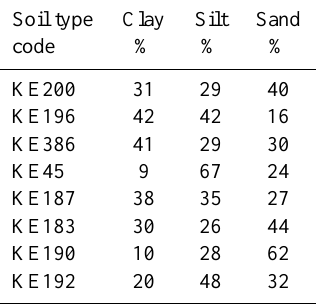
Fig. 3. Nyangores sub-basin soil types (FAO Soil Figure 3. Nyangores sub-basin soil types (FAO Soil database).